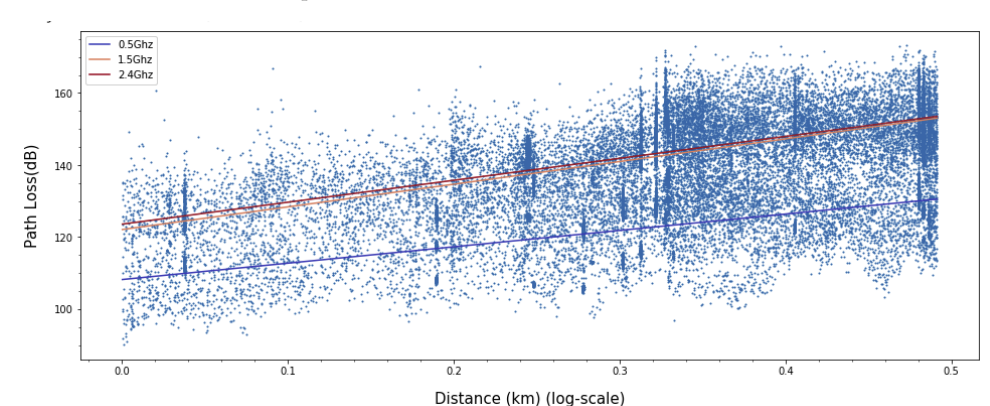
Figure 13. Path loss prediction based on linear model.